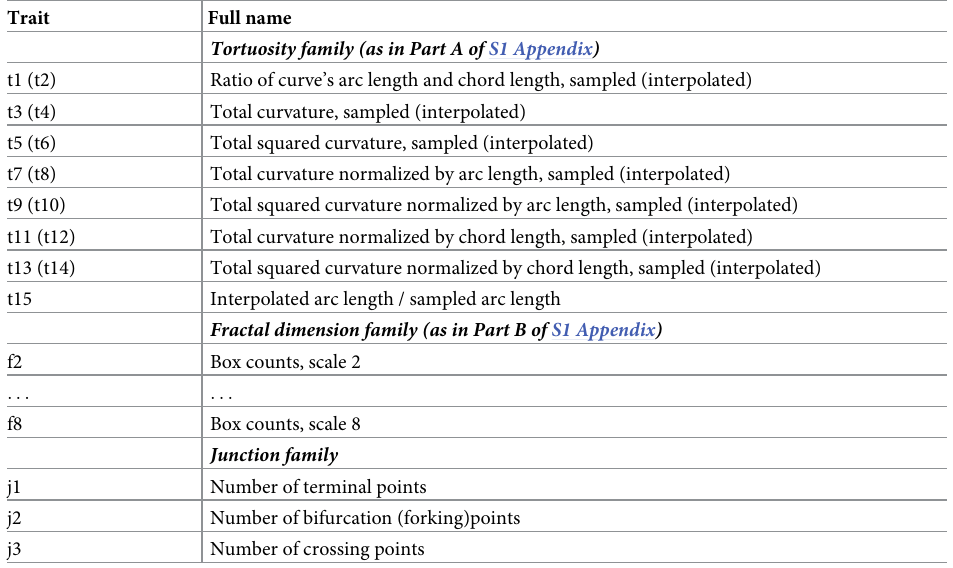
Table 1. Definition of microvascular traits.